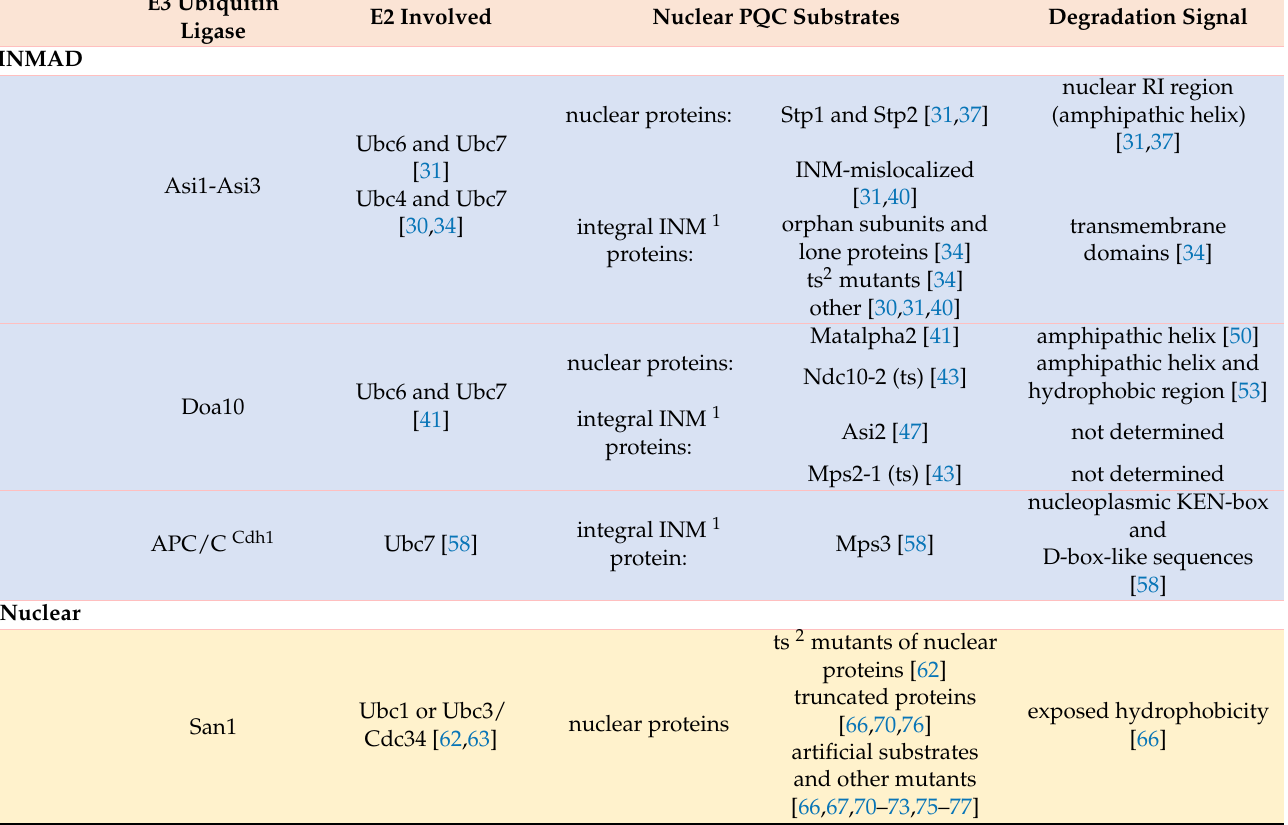
Table 1. Nuclear ubiquitin-proteasome pathways for degradation of protein quality control (PQC) substrates in yeast. E3